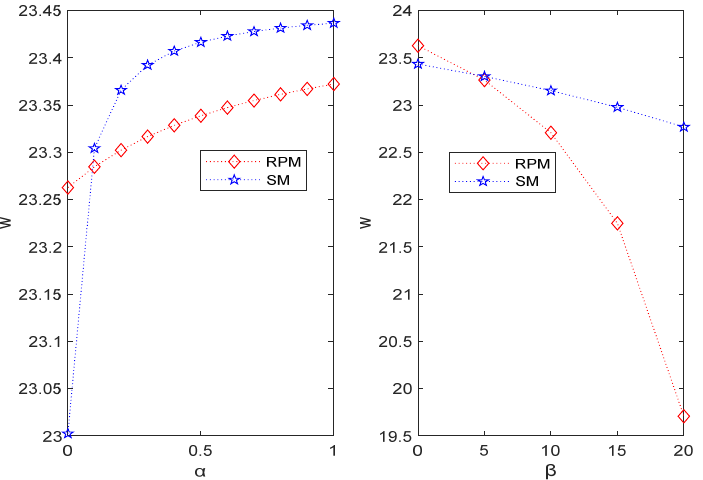
Figure 5. Wholesale price under RPM and SM vs. fixed cost coefficient ( left ) and environmental benefit coefficient ( right ).